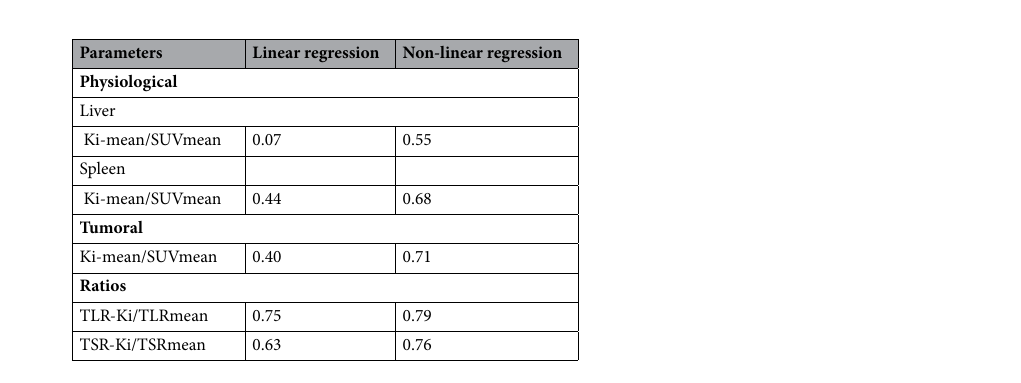
Table 5. Coefficient of determination (R 2 ) between static and dynamic parameters using a linear and a non- linear